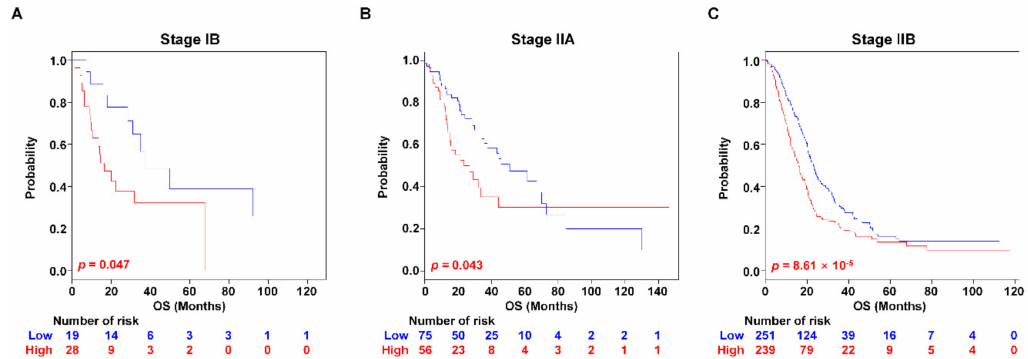
Figure 4. Kaplan–Meier survival analysis of PAC patients with stage IB, IIA, and IIB. ( A – C ) Kaplan–Meier survival analyses were performed to estimate the di ff erences in OS between